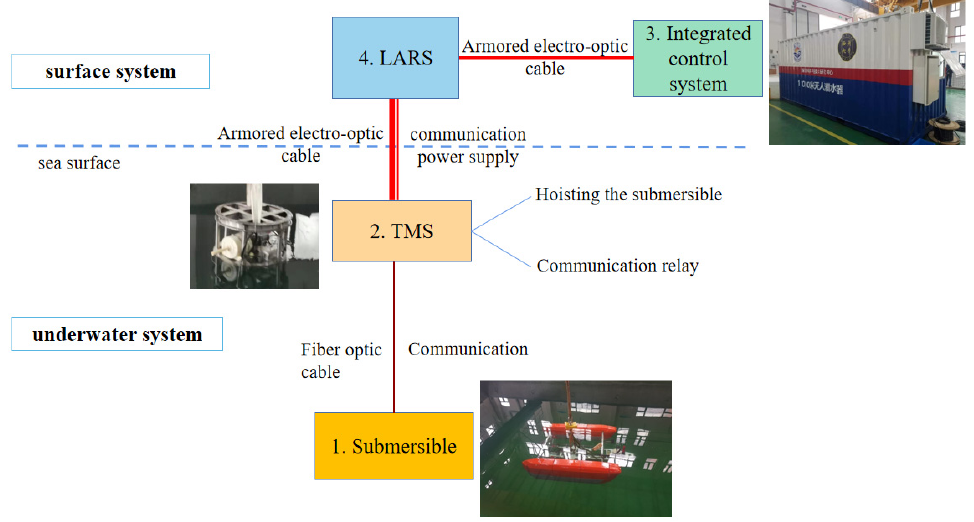
Figure 1. The whole system illustration of the ARV Dream Chaser.